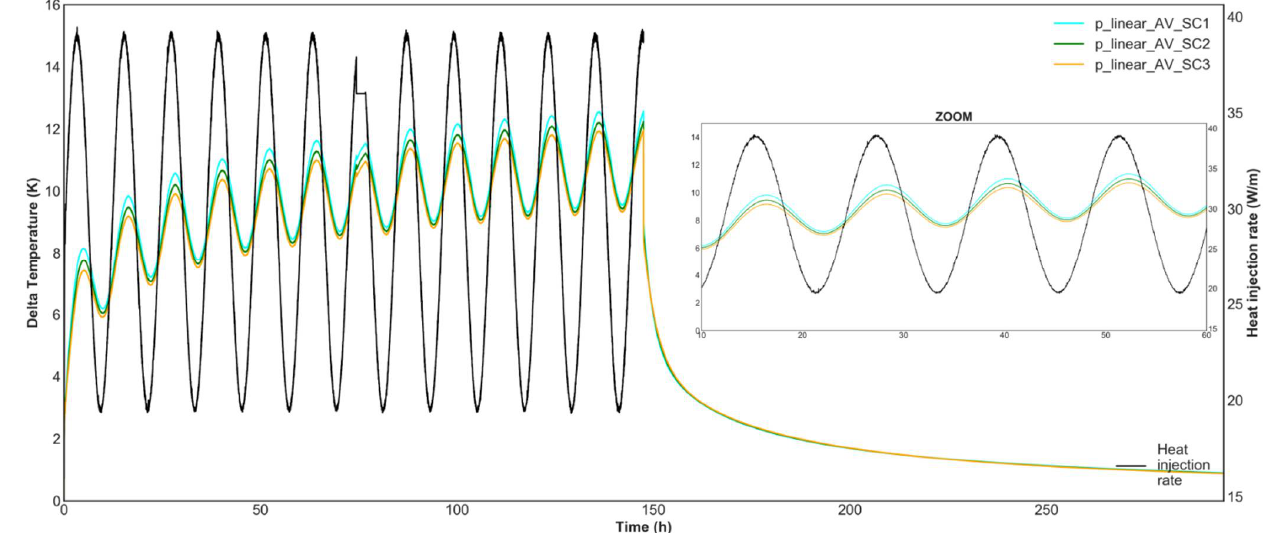
Figure 8. Numerical simulation of OTRT for the three subsurface scenarios. R p inferred from simulated temperature ranges from 0.155 to 0.135, decreasing with increasing HC from SC1 to SC3. On the other hand, the phase shift does not present any significant difference among the scenarios, with F at 0.11 in the three cases (Table 3). TD p shows maximum deviation D (%) from the expected values of 25%, 9% and 2% in SC1, SC2 and SC3, respectively, when the estimation is carried out by means of the oscillatory resistance (Equation (5), Table 4). However, the TD estimation from the phase shift returns deviations > 30%. Similarly, the HC is evaluated with deviations < 20% through R p , and deviations > 50% through F (Table 5). Interestingly, the higher the subsurface HC, the p better the estimation of TD and